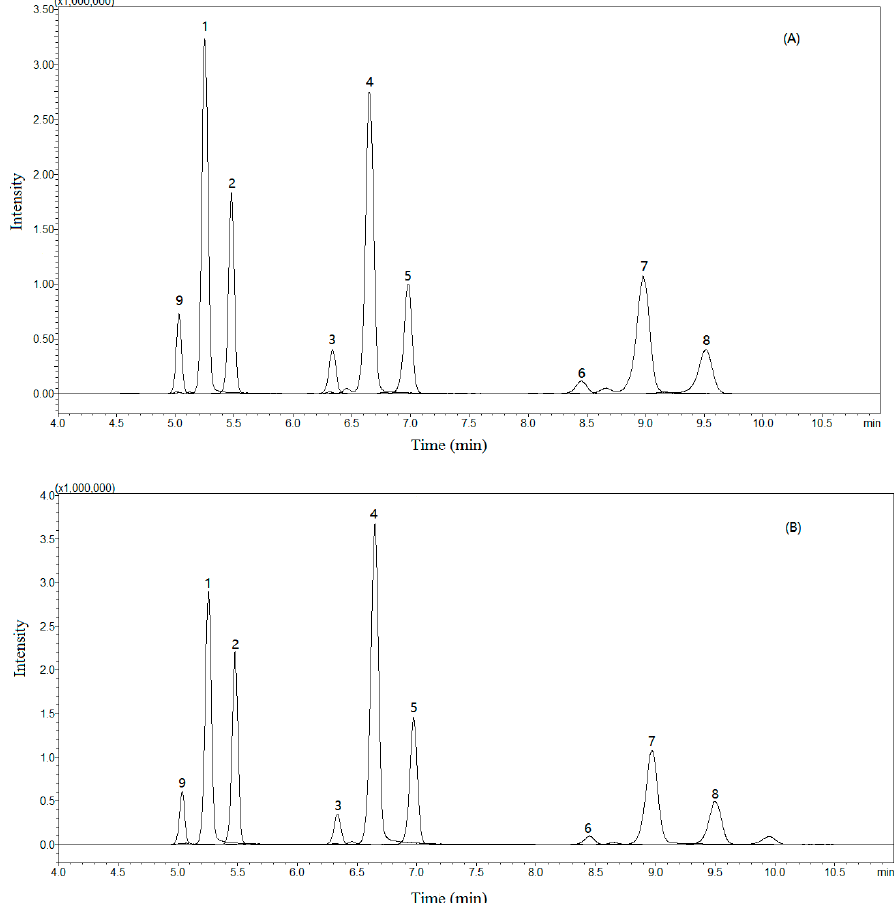
Figure 2. Typical total-ion multiple reaction monitor (MRM) chromatograms of the sample solution ( A ) and standard solution ( B ) obtained in positive-ion mode. Andafocoumarin A ( 1 ), andafocoumarin B ( 2 ), andafocoumarin C ( 3 ), andafocoumarin D ( 4 ), andafocoumarin E ( 5 ), andafocoumarin F ( 6 ), andafocoumarin G ( 7 ), andafocoumarin H ( 8 ), and andafocoumarin J ( 9 ).